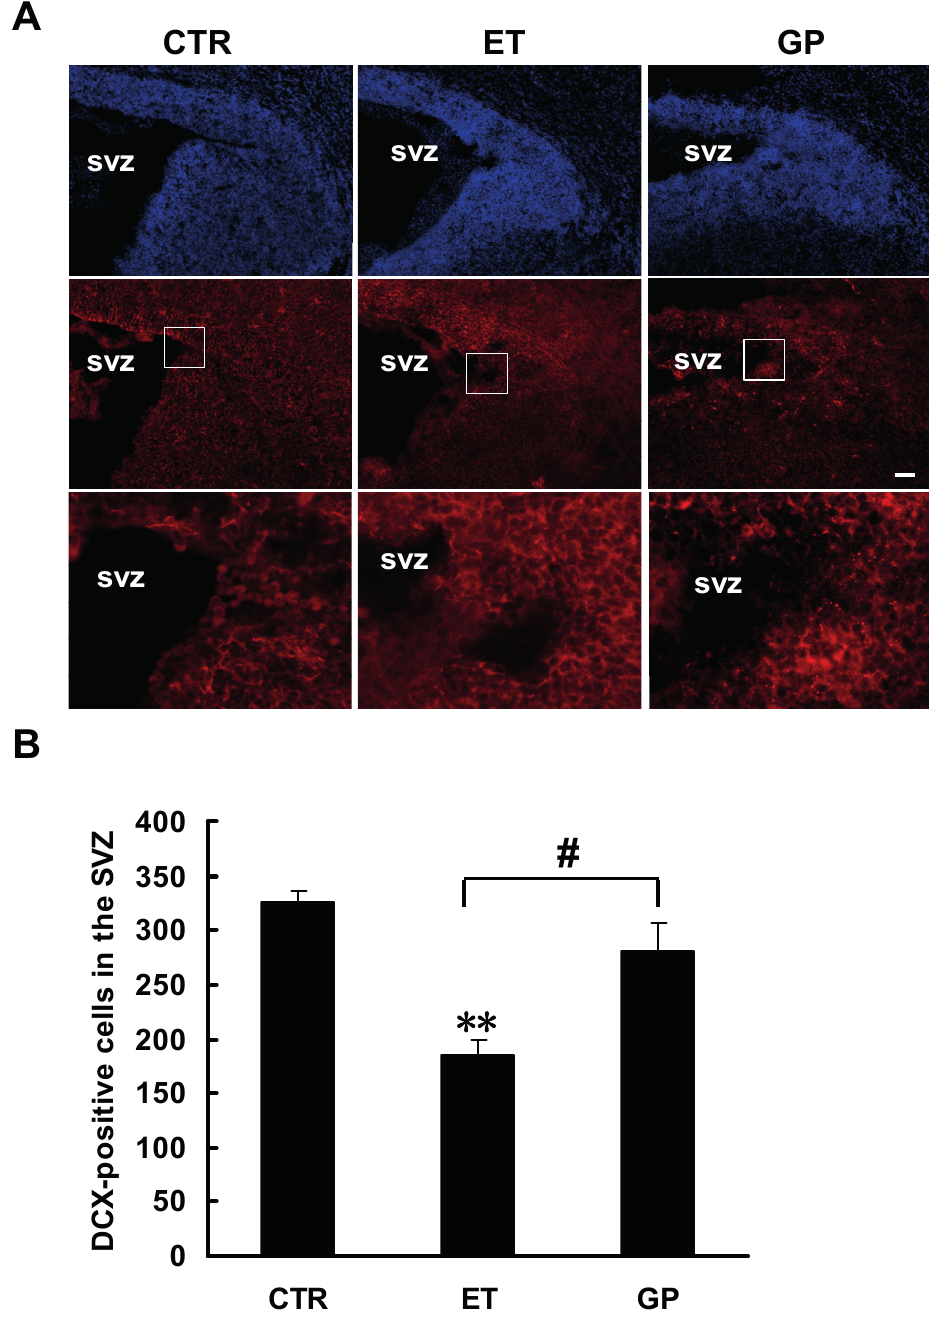
Figure 3. GPs increase the number of DCX-positive cells in the SVZ of the neonatal brain that was inhibited by ethanol. ( A ) Immunohistochemical staining for DCX was labeled in the SVZ of neonatal FASD rats. DAPI (blue) labeled all nuclei. Scale bar = 200 μ m. The outlined rectangular fields are respectively shown at higher magnification in the lower pictures; ( B ) Quantitative analysis of the number of DCX-positive cells in the